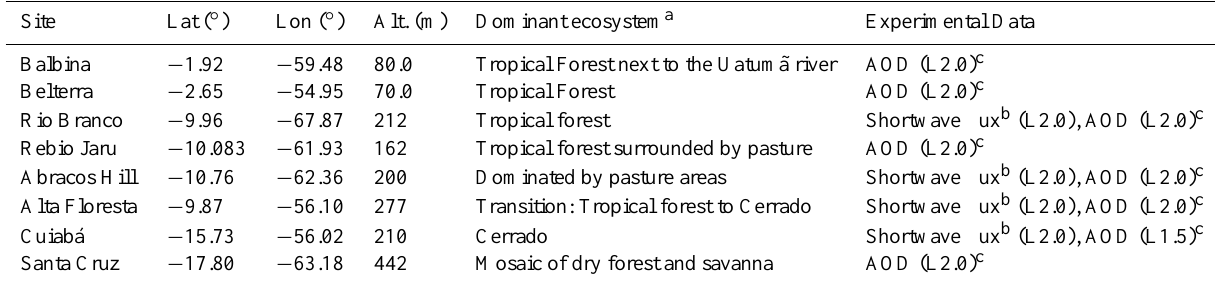
Table 1. Geographic locations of the experimental sites, dominant biomes and available